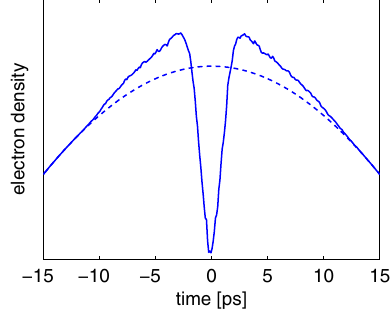
FIG. 1. Simulated charge distribution of the sliced electron bunch as a function of time immediately after